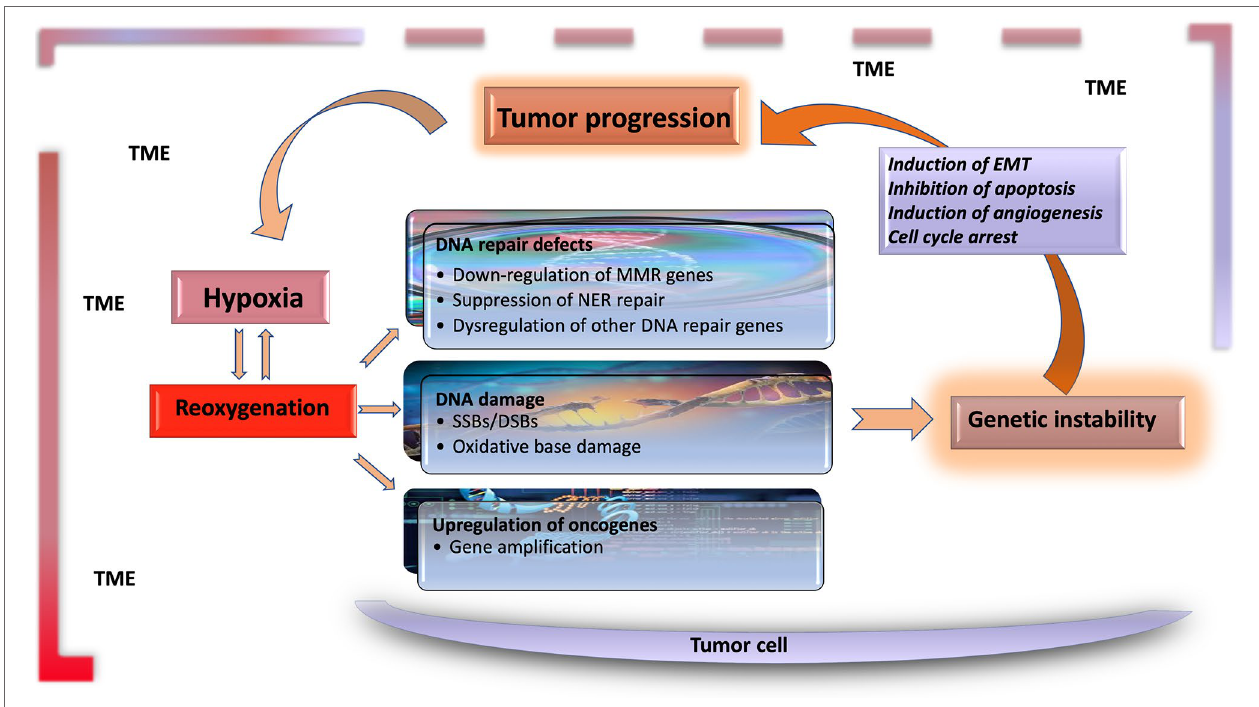
FIGURE 1 | Hypoxia is the major contributor to genomic instability in the tumor microenvironment. Along with inherited changes and the effect of environmental carcinogens, the factors resulting from tumor microenvironment contribute to genomic instability during tumor progression. DNA changes caused by hypoxia– reoxygenation cycles in the tumor microenvironment are an essential source of genomic instability. Functional genetic changes caused by these mutations lead to inhibition of apoptosis, and induction of angiogenesis and EMT, leading to further progression of tumor tissue and the carcinogenic microenvironment. TME, tumor microenvironment; EMT, epithelial–mesenchymal transition; MMR, mismatch repair; NER, nuclear excision repair; SSB, single-strand break; DSB, double-strand break.